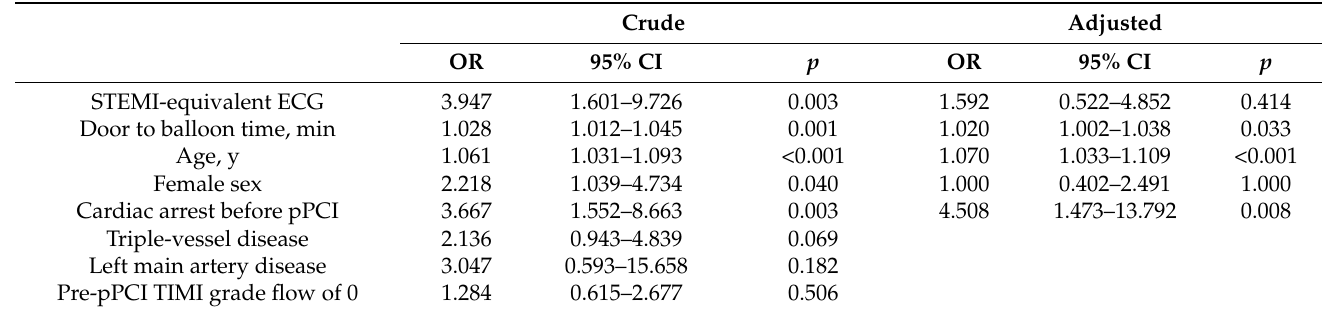
Table 5. Univariable and multivariable logistic regression analyses for predicting in-hospital major adverse cardiovascular